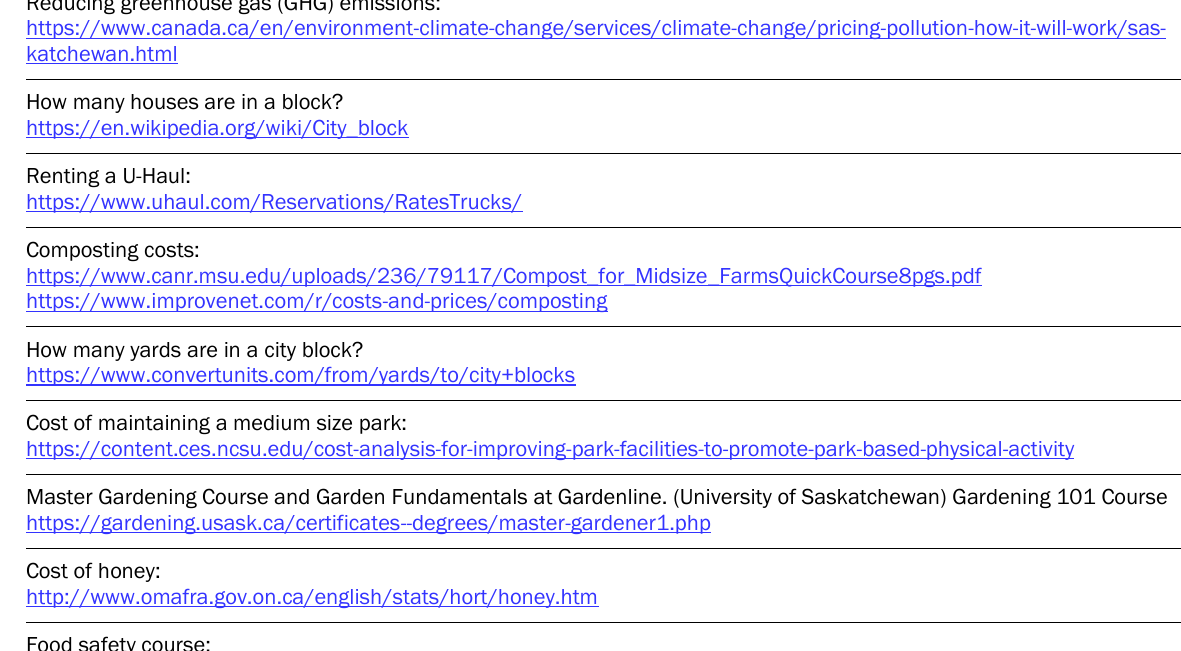
Table C1. Financial Proxies and